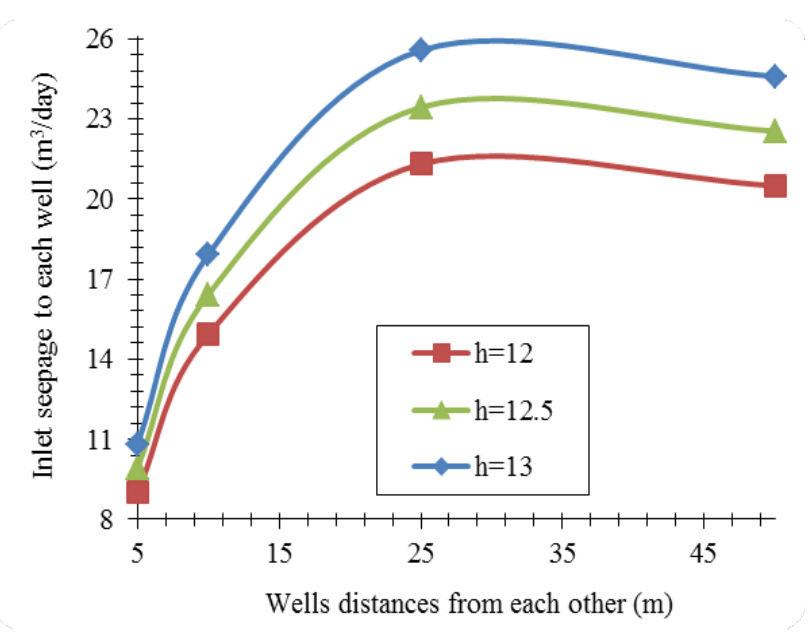
Fig. 9. Effect of upstream reservoir level on seepage flow to each well (well radius is 0.5